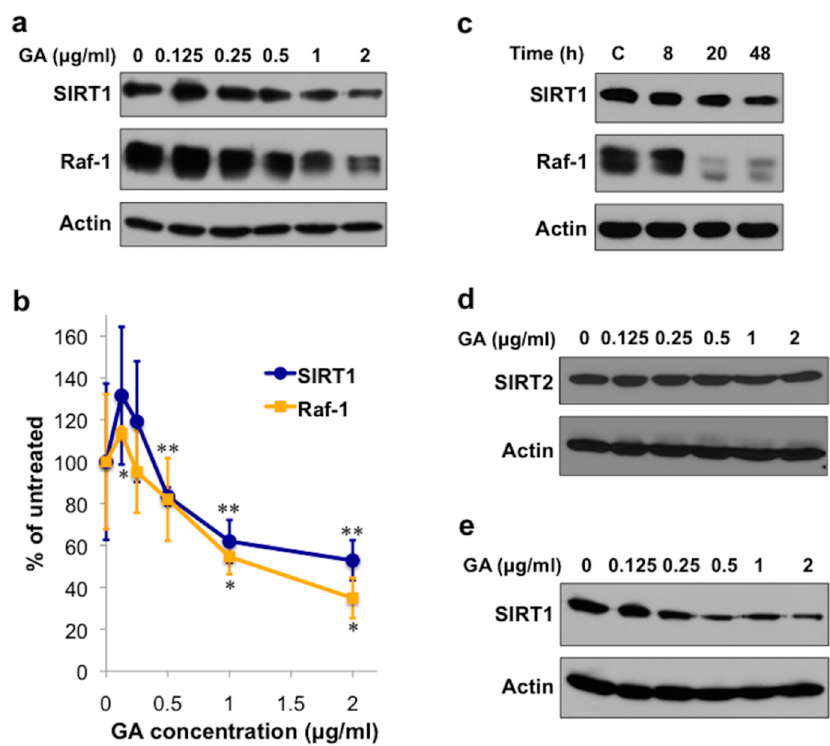
Figure 1. Hsp90 inhibition depletes SIRT1 protein in COS-7 and HepG2 cells. ( a ) Effect of GA on SIRT1 and Raf-1 protein levels. Western blots of lysates from COS-7 cells treated by GA for 20 h. Images are representatives of three experiments for SIRT1 and two experiments for Raf-1. ( b ) Quantification of protein levels from the experiment shown in panel ( a ). Values are means ± S.D. of three (SIRT1) or two (Raf-1) experiments and were statistically compared with the respective untreated controls. * p < 0.05, ** p < 0.01 by two-tailed unpaired t -test. ( c ) Timescale of GA treatment on SIRT1 and Raf-1 protein levels. Western blots of lysates from COS-7 cells treated by 1 µ g/mL GA for the indicated times. Images are representatives of two experiments. C: 48 h vehicle control. ( d ) Effect of GA on SIRT2 protein level. Western blots of lysates from COS-7 cells treated with GA for 20 h. Images are representatives of two experiments. ( e ) Effect of GA on SIRT1 protein level in human hepatoma cells. Western blots of lysates from HepG2 cells treated by GA for 48 h. Images are representatives of two experiments.